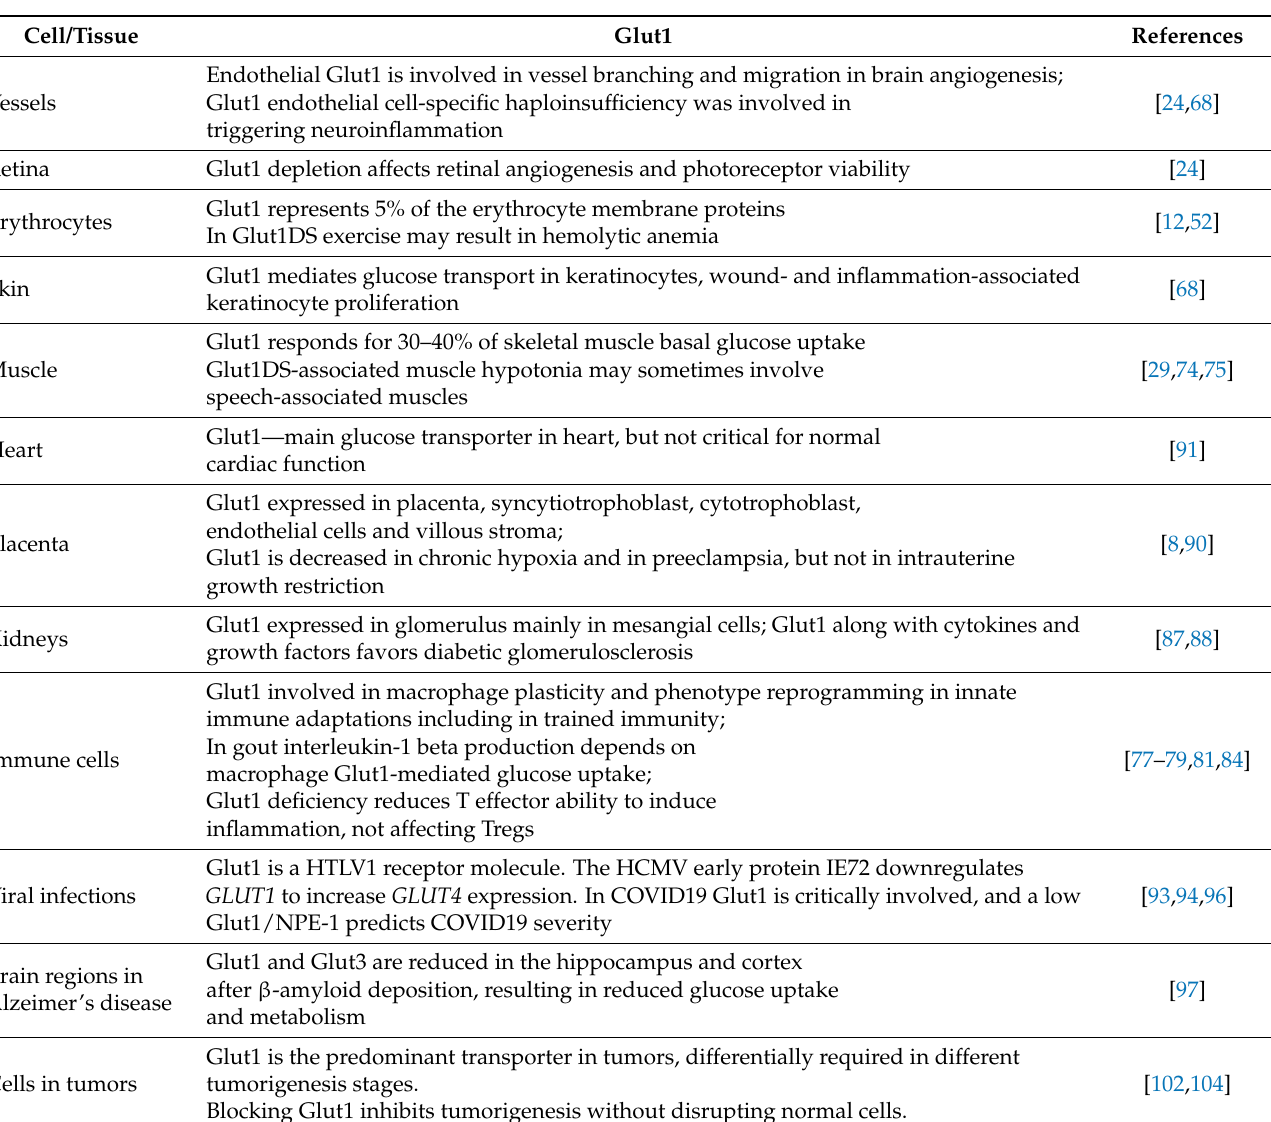
Table 3. Glut1 in other settings: functional